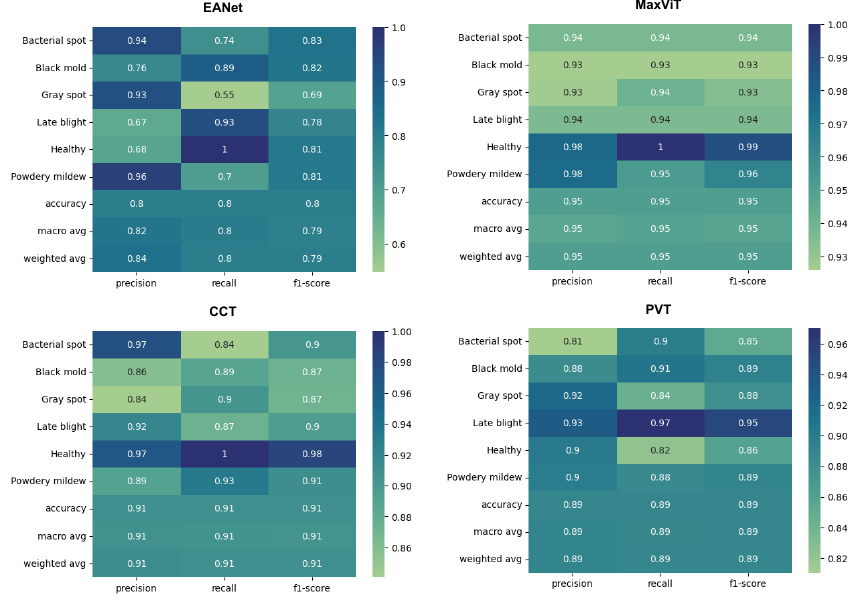
Figure 14. Classification report.